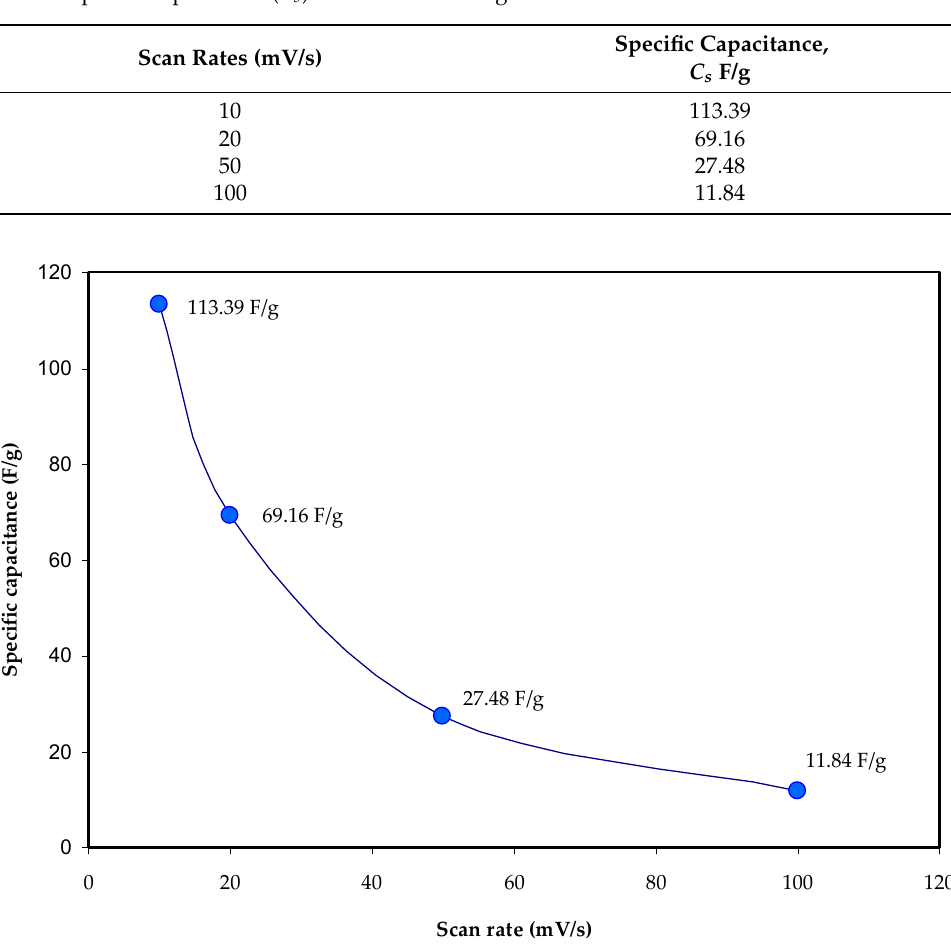
Table 3. Specific capacitance ( C s ) of the EDLCs using CV curves.